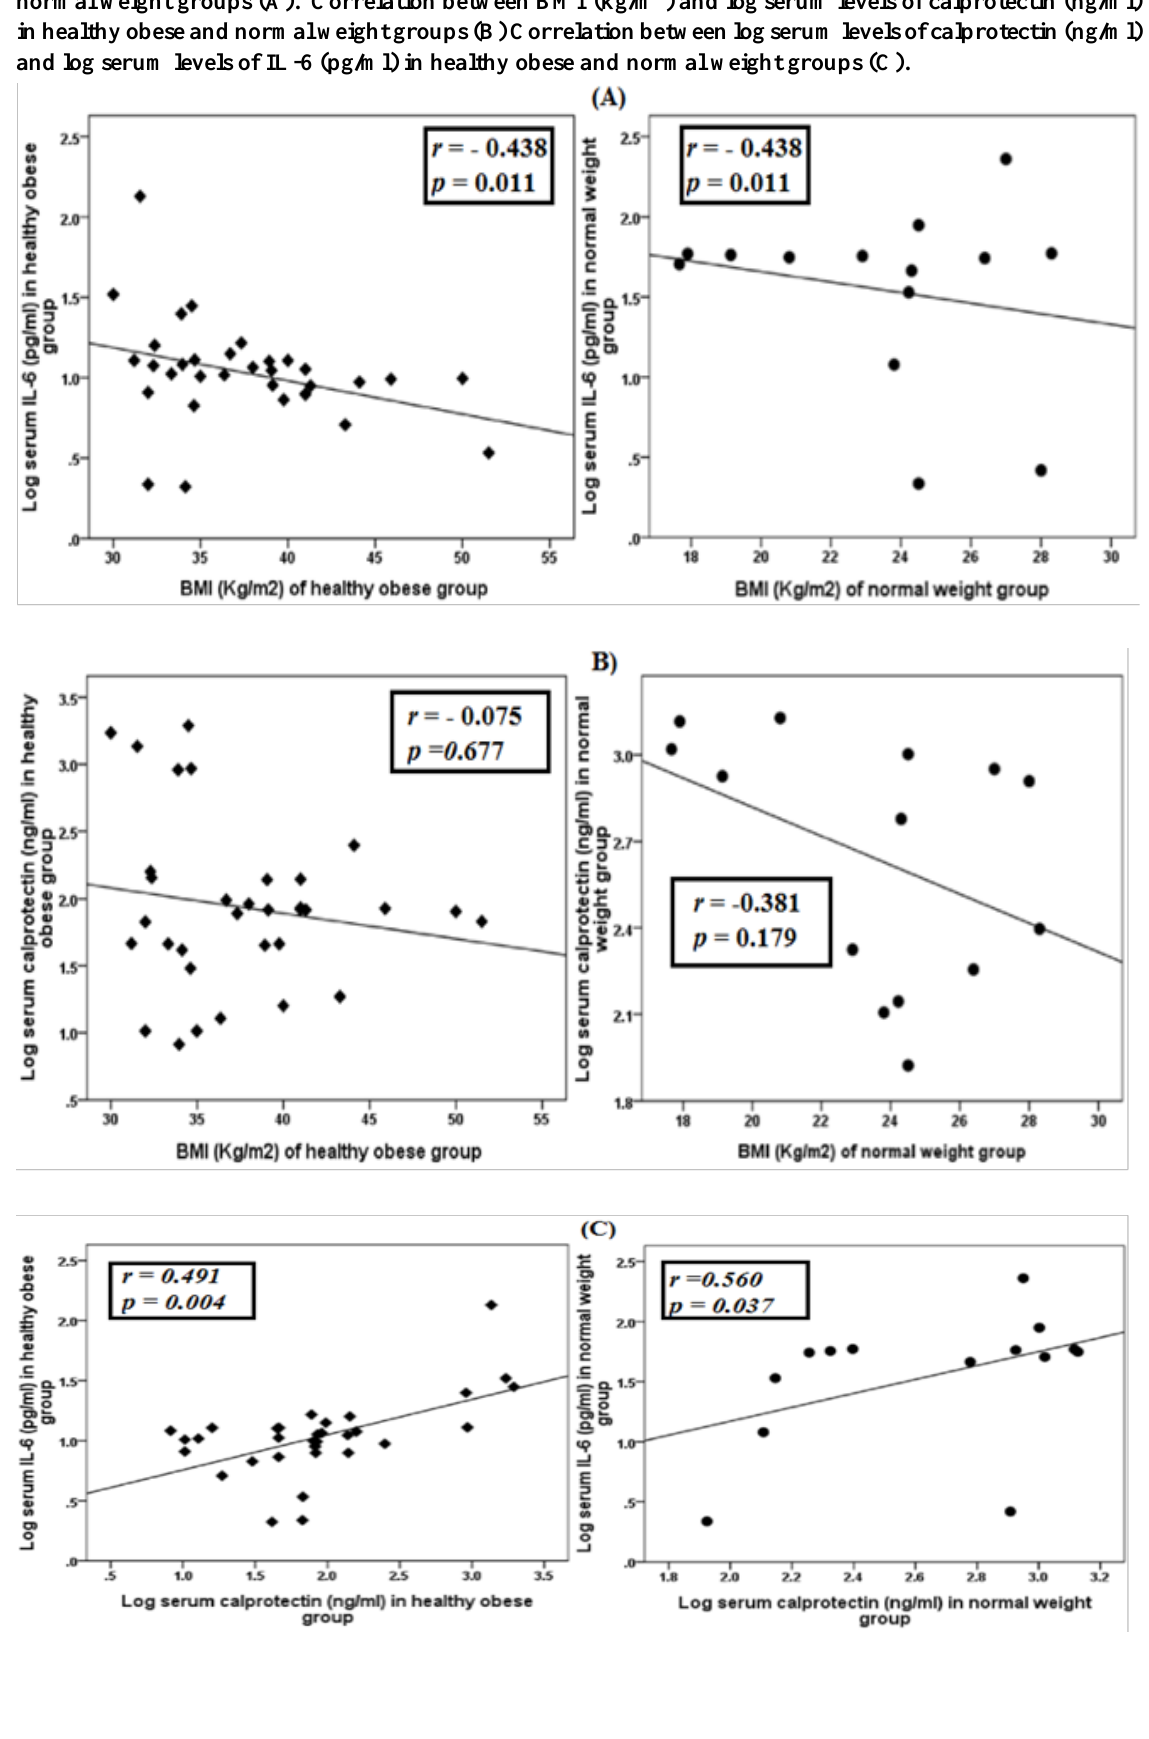
Figure 2. Correlation between BMI (kg/m 2 ) and log serum levels of IL-6 (pg/ml) in healthy obese and normal weight groups (A). Correlation between BMI (kg/m 2 ) and log serum levels of calprotectin (ng/ml) in healthy obese and normal weight groups (B) Correlation between log serum levels of calprotectin (ng/ml) and log serum levels of IL-6 (pg/ml) in healthy obese and normal weight groups